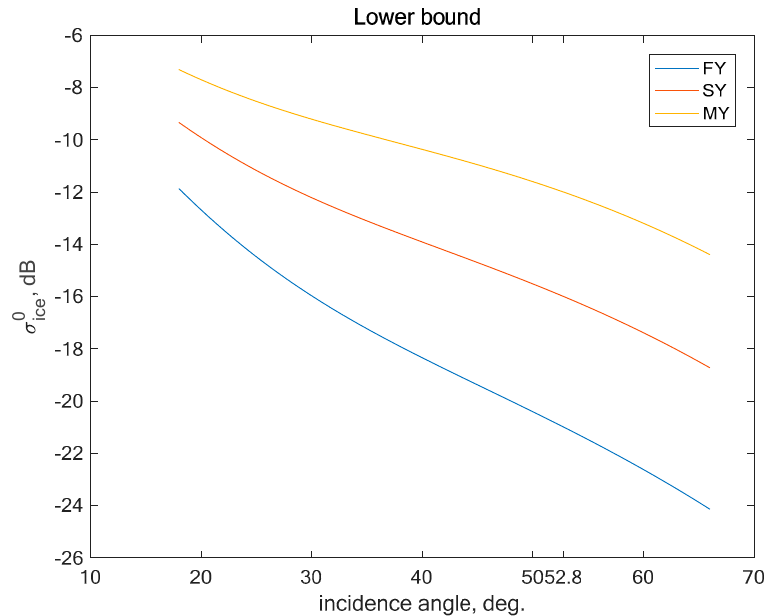
cell (number of beams in the case of multiple fan-beam geometry), σ NRCS value, and σ i -measured NRCS value.